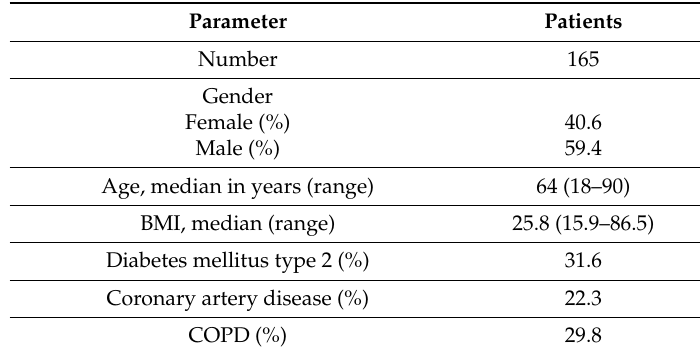
Table 1. Baseline patient characteristics at the time point of admission and calprotectin serum concentrations at day 1 and day